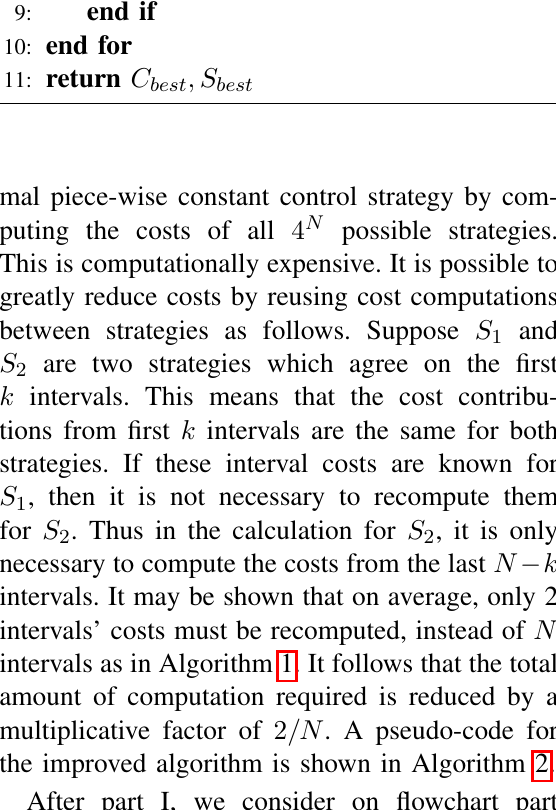
An enumerative algorithm for finding a near- optimal strategy from among these strategies pro-